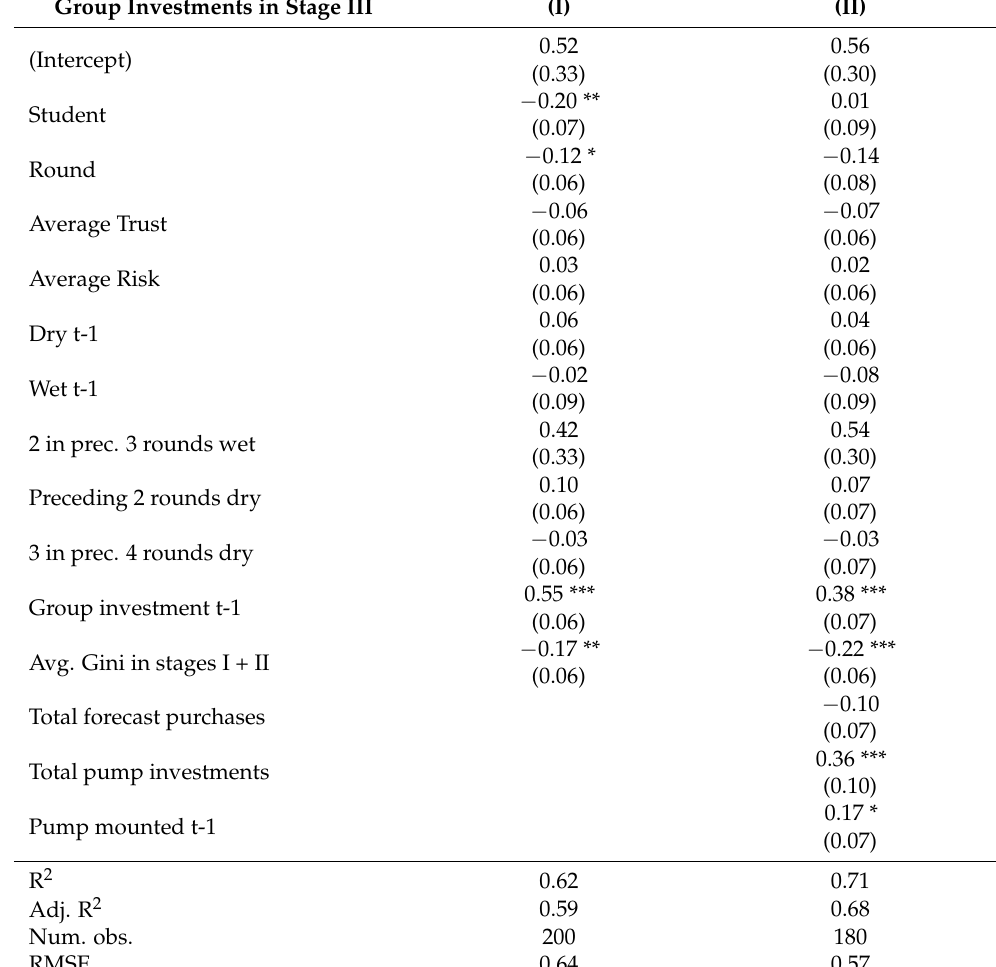
Table 7. Group-level regression results (group investments in channel